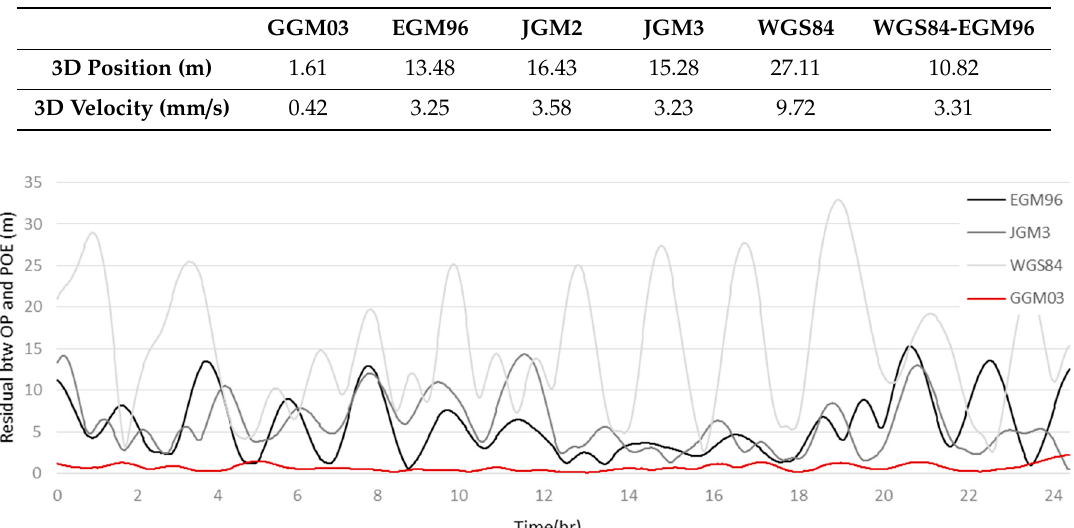
Table 3. Performance analysis results in 1 sigma of various orbit propagation models with respect to the reference orbit, CHAMP precise orbit ephemeris (POE).